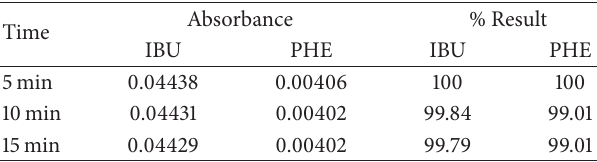
Figure 6: Overlain D 1 spectrum of Phenylephrine HCL (1.5– 22 ppm) in 0.1N NaOH. Table 3: Robustness (measuring absorbance at different time).